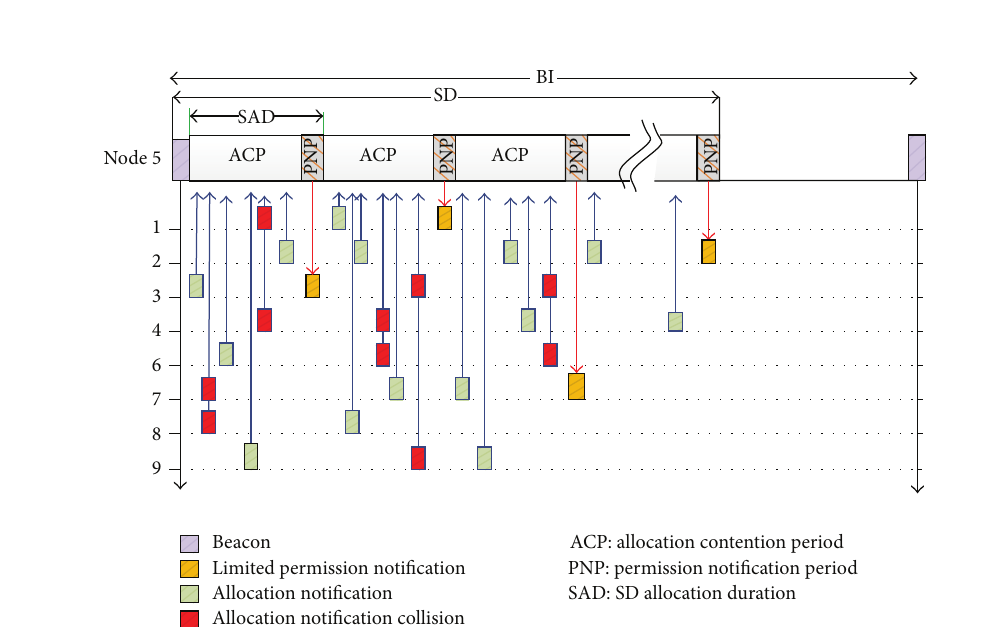
Figure 10: Limited permission notification.